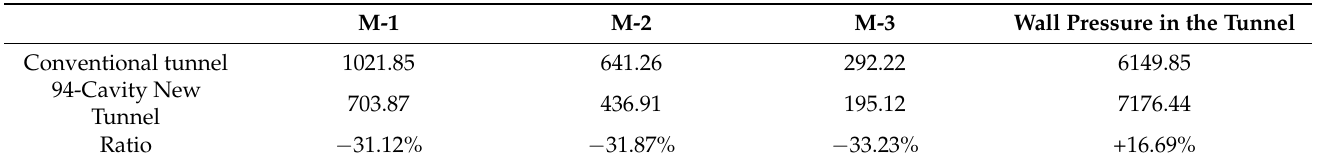
Figure 11. Effect of different solutions on micro-pressure waves. ( a ) M-2; ( b ) M-3 . Table 3. Comparison of results of different solutions. Table 3. Comparison of results of different solutions